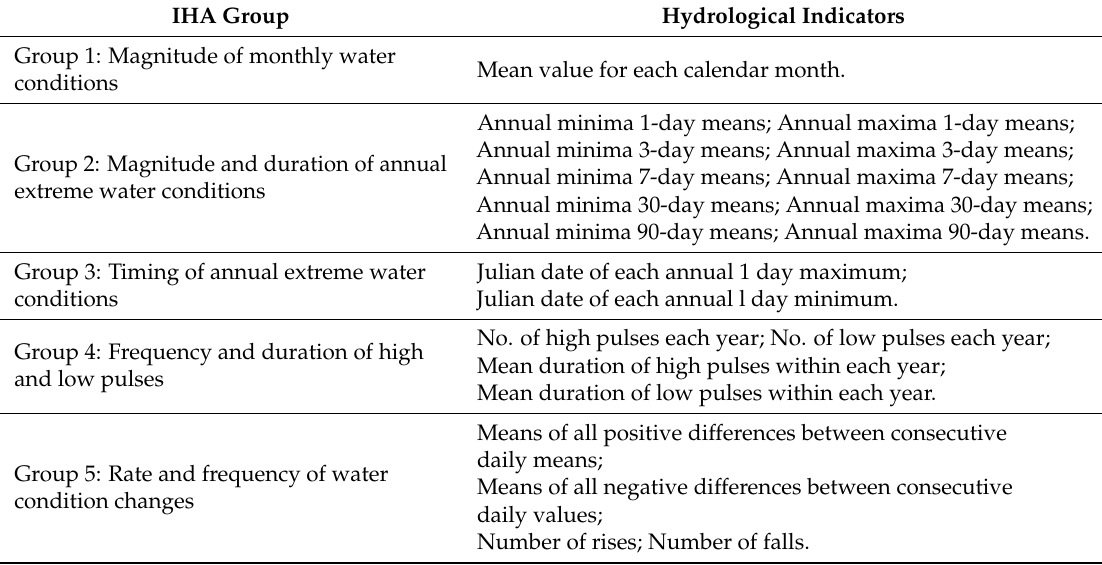
Table 2. Indicators of hydrological alteration (IHA) in the range of variability approach. IHA Group Hydrological